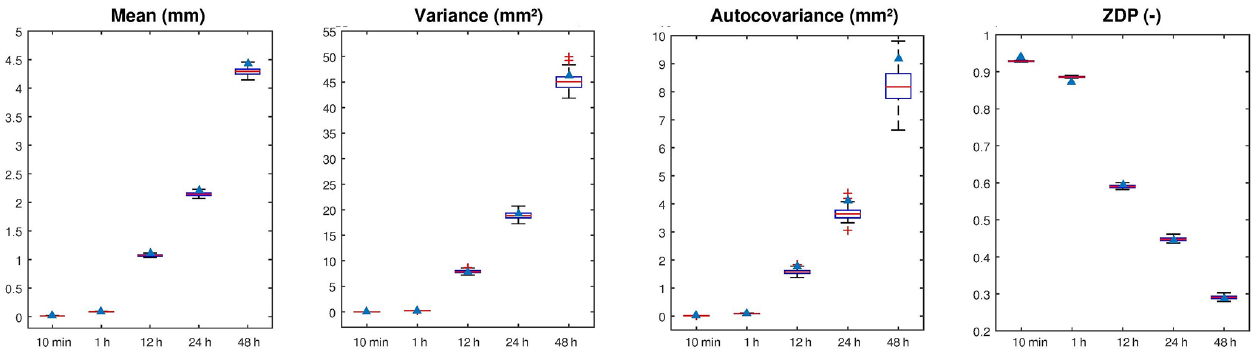
Figure 8. Comparison between observed and simulated precipitation data for the mean, variance, autocovariance and zero-depth probability (ZDP): Uccle is shown by the blue triangles and the ensemble of 50 simulated time series by the MBL model is shown by the box plots.